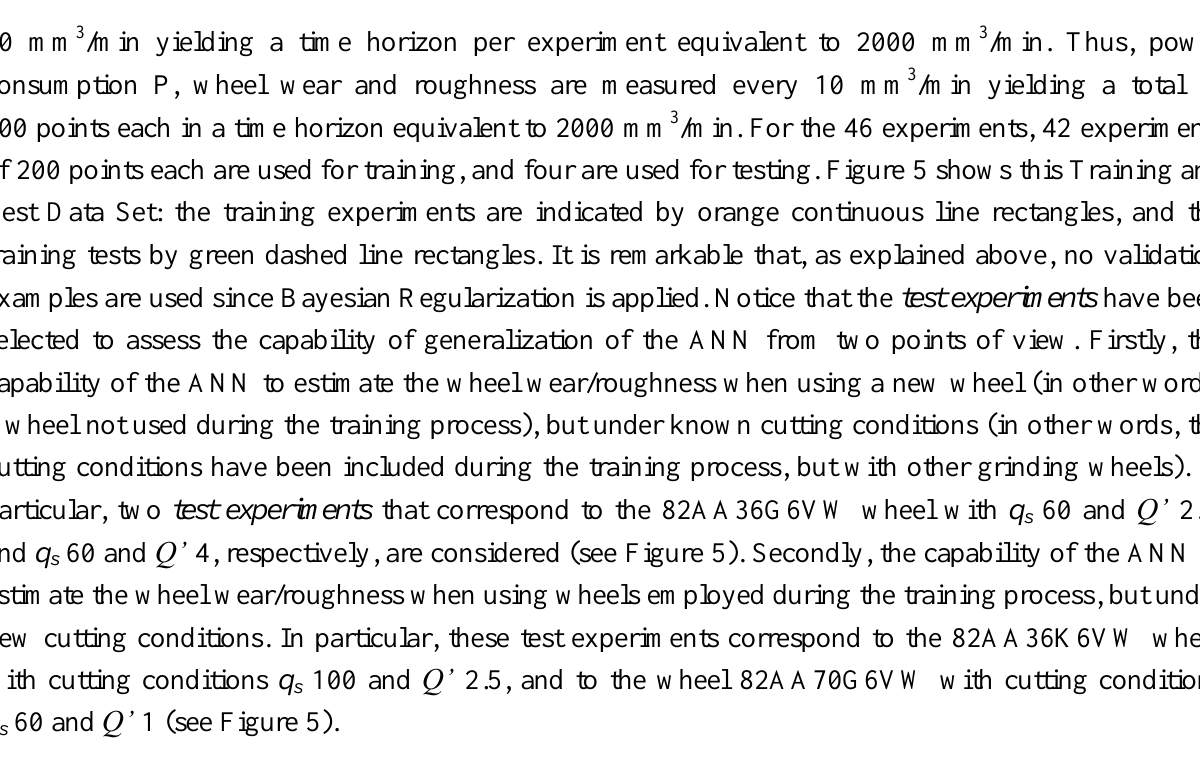
Figure 5. Training and Test Data Set